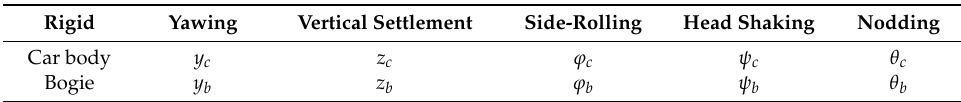
Table 2. The Degree of Freedom (DOF) of the vehicle model.